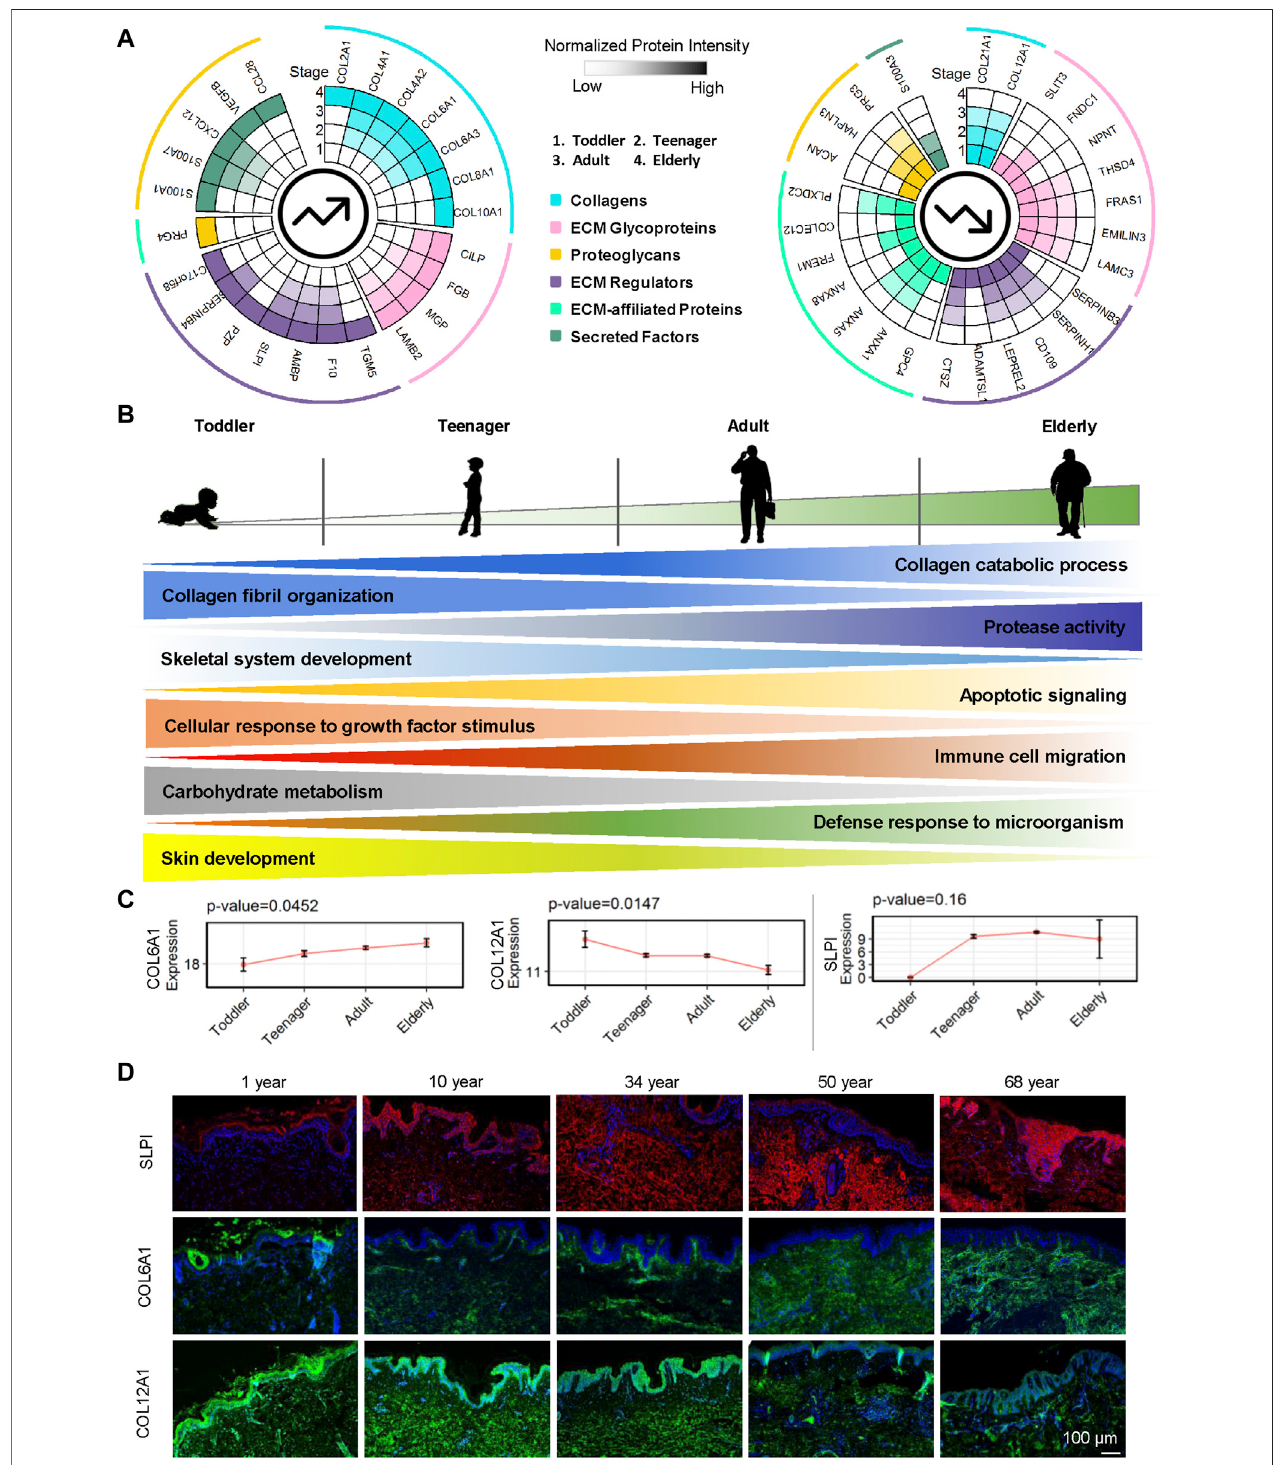
FIGURE 5 | Roles of ECM proteins in human dermal development. (A) Upregulated and downregulated ECM proteins in the human skin dermis at four ages (toddler,teenager,adult,andelderly).Eachcirclerepresentsanagestage.Blue,pink,yellow,purple,green,andcyanlinescorrespondtothesixcomponents(collagens, ECM glycoproteins, proteoglycans, ECM regulators, ECM-af fi liated proteins, and secreted factors) of the skin ECM. (B) Schematic representation of dermal ECM function evolution during human skin development and aging. (C) Expression of COL6A1, COL12A1, and SLPI in skin scaffolds of four ages (toddler, teenager, adult, and elderly). (D) Immuno fl uorescence of SLPI, COL6A1, and COL12A1 identi fi ed in the human skin dermis (scale bar represents 50 μ m).